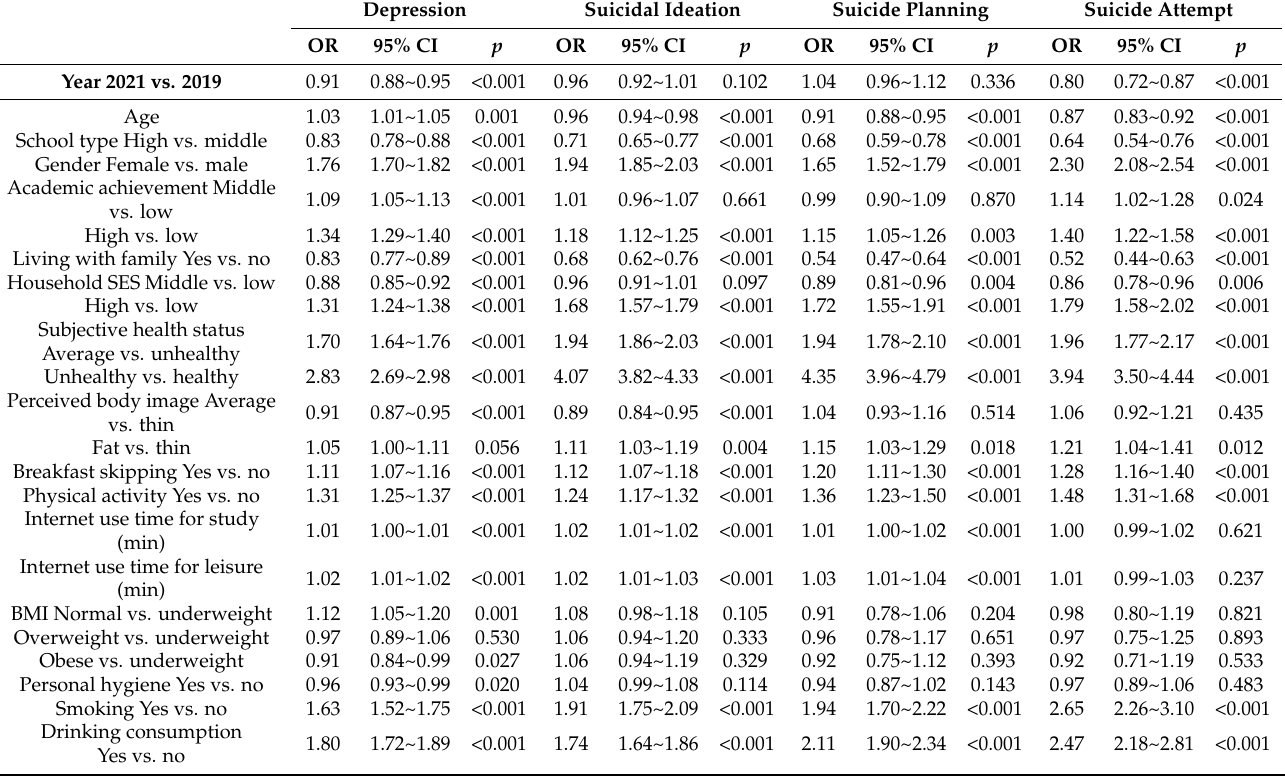
Table 5. Changes between 2019 and 2021 in the relationships of the general and health-related characteristics with the suicide-related